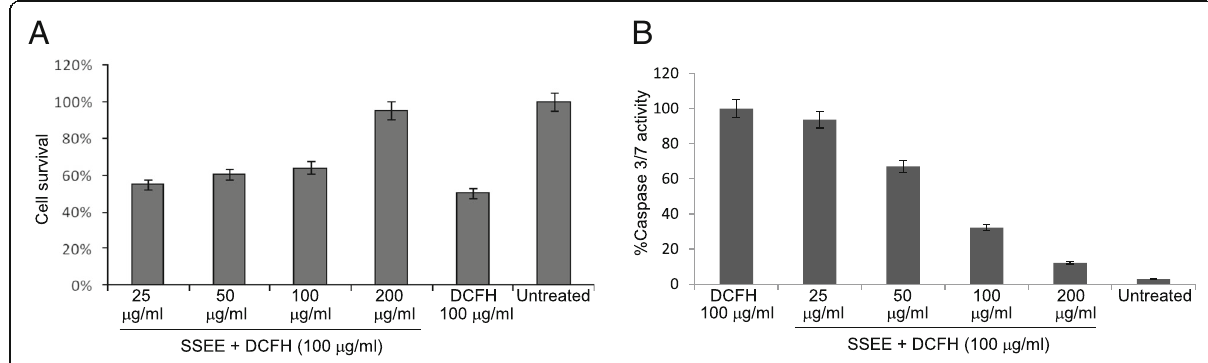
Fig. 1 In vitro protection of cultured HepG2 cells by S. surattense ethanol-extract (SSEE). a MTT Cell proliferation assay showing attenuation of